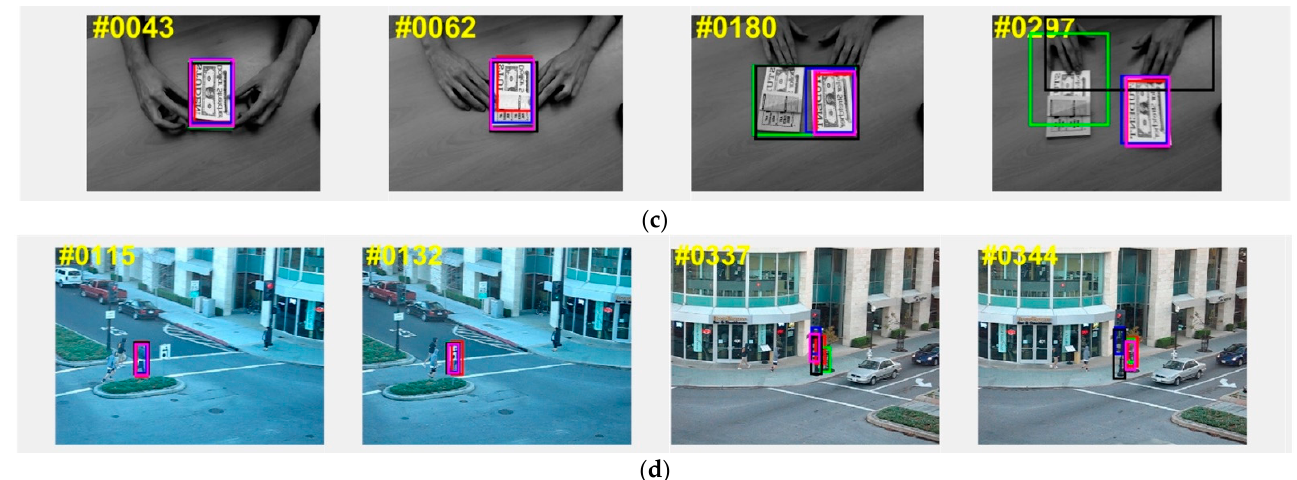
Figure 13. Case study on OTB100 for our SiamHAS and several state-of-the-art trackers. From the top to bottom, the pictures show the visual case experiment results on the image sequences of ( a ) Bird1, ( b ) lemming, ( c ) Coupon, and ( d ) human4. Red—Ours, Green—SiamCAR, Blue—SiamRPN++, Black—SiamRPN, and Pink—SiamFC.